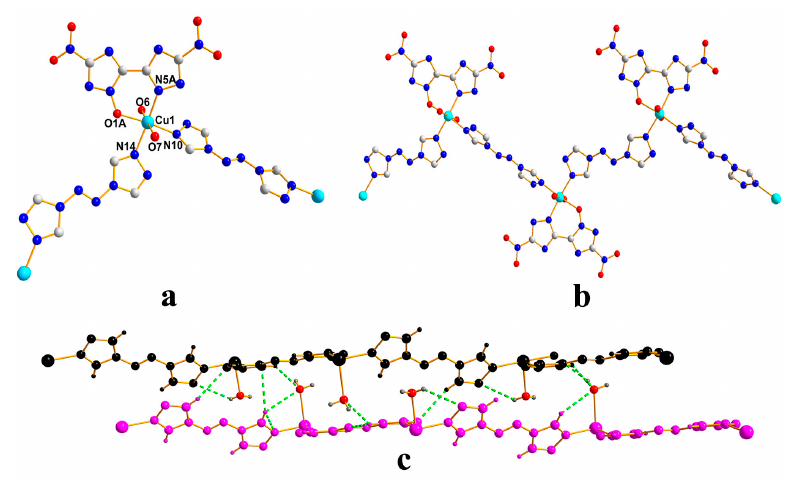
Figure 2. ( a ) Coordination environment of Cu(II) in 2 ; ( b ) 1D chain in 2 ; ( c ) 2D network in 2 formed by hydrogen-bonding interactions.